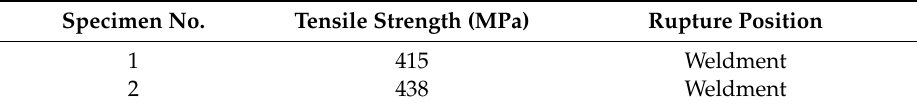
Table 7. Tensile test results of the weldments.